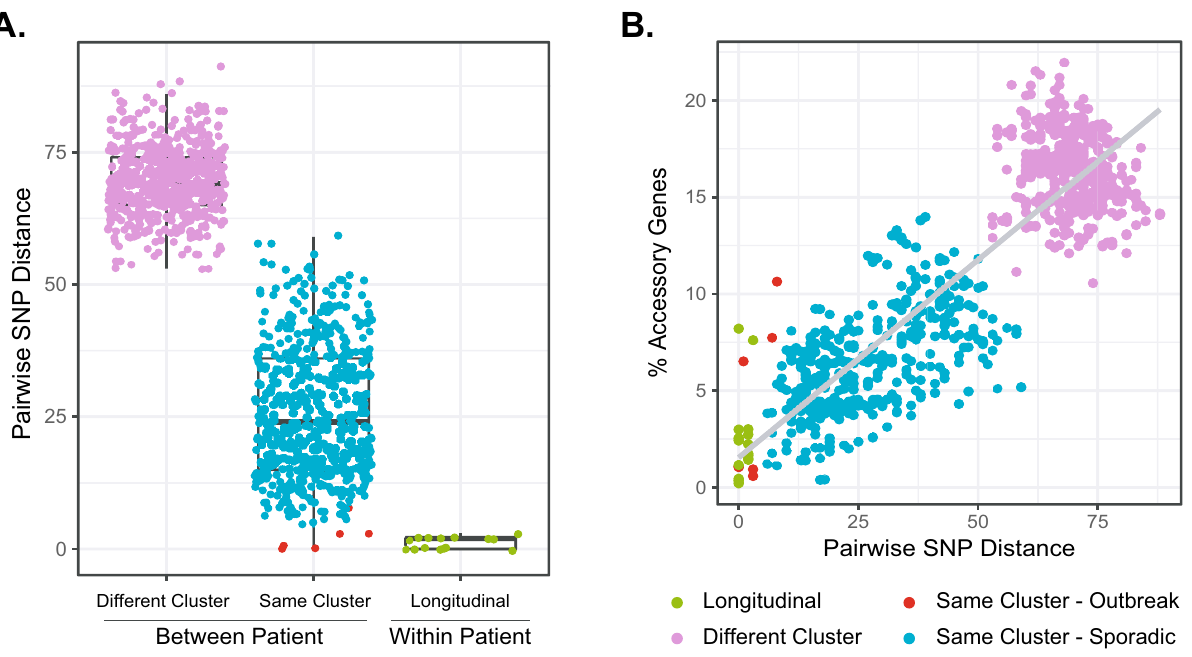
Figure 4. Pairwise genomic variation among Clone 1 M. massiliense isolates. Pairwise SNP distances were calculated for all Clone 1 isolates in the study (n = 58). ( A ) Isolate pairs are categorized as between-patient or within-patient. Between patient isolates in the same cluster (Cluster 1 or Cluster 2) are further categorized as belonging to known outbreaks (red) or as sporadic, unrelated isolates (blue). ( B ) The relationship between accessory gene content for Clone 1 isolate pairs, measured as % accessory genes for each isolate pair (# accessory genes/# of genes in pan genome) and core genome similarity (shown as pairwise SNP distance) is shown as a scatter